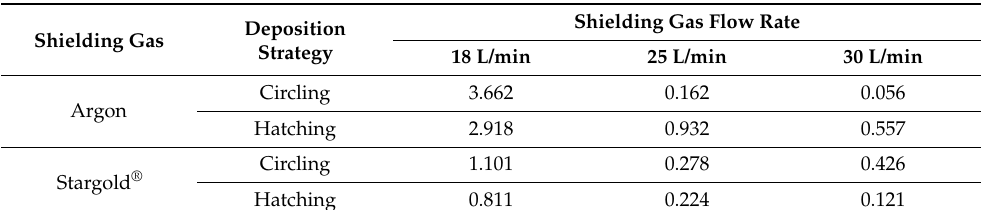
Table 4. Porosity area percentage (%) with different fabrication configurations.